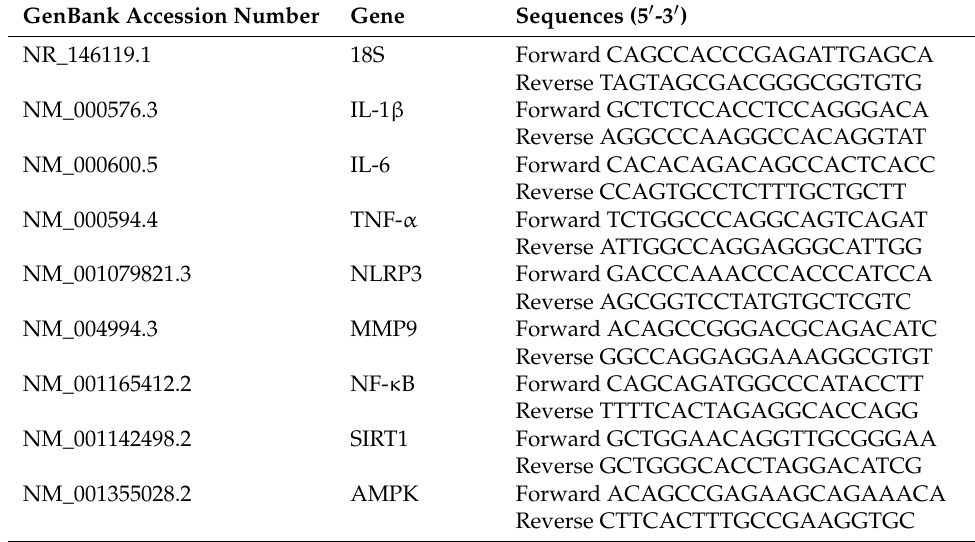
Table 1. Primer sequences for the target